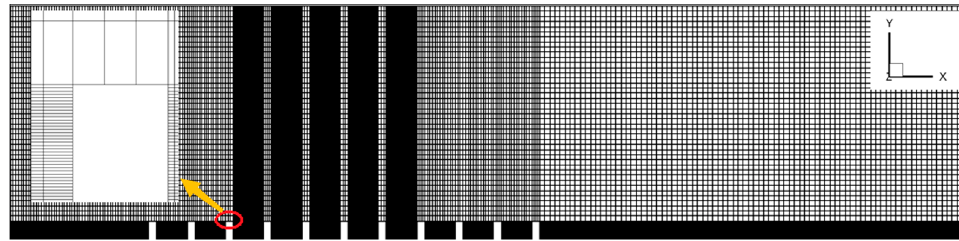
Figure 5. Schematic diagram of the x-y section grid.